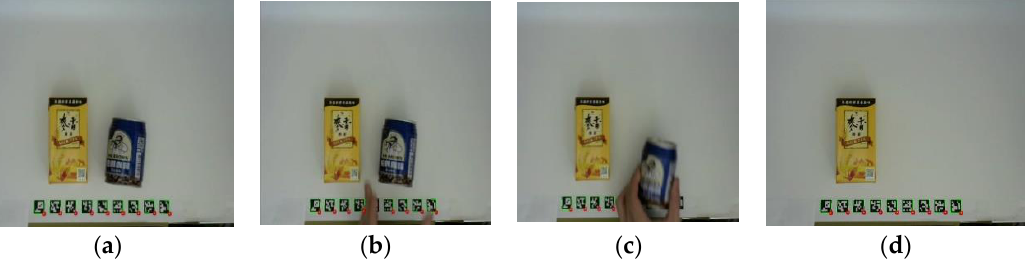
Figure 3. Marker function. ( a ) Normal condition; ( b ) Hand passing; ( c ) An item is moving; ( d ) Item taken.